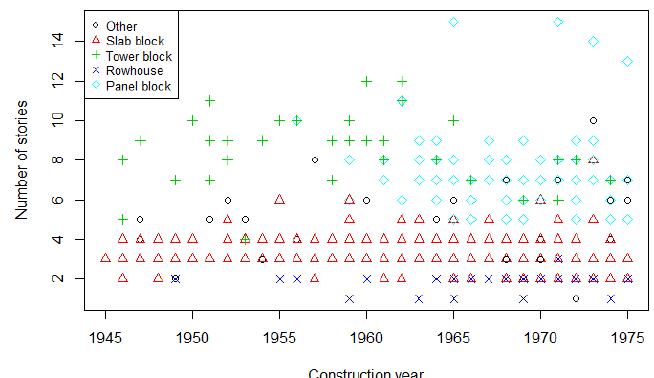
Figure 5. Visualisation of how construction year (x) and number of stories (y) correlate with building type. It can be seen that building types tend to form clusters, indicating that the x and y variables together succeed to differentiate between building types. It should be noted that one point in the figure sometimes corresponds to several identical observations, which explains why the total number of points is lower than 514.